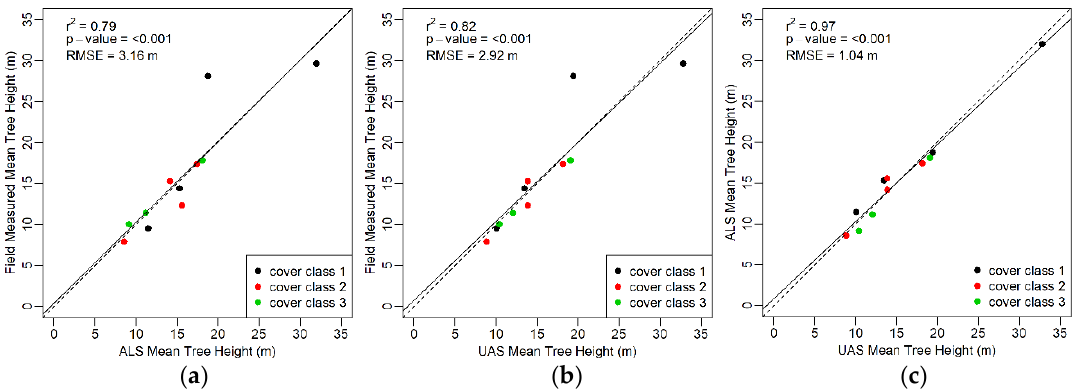
Figure 6. ( a ) ALS-based and ( b ) UAS-photogrammetry-derived estimates of mean tree height vs. field-measured counts or ( c ) vs. the opposing remote sensing method by canopy cover class. The solid line displays a linear regression fit and the dashed line the 1:1 line.